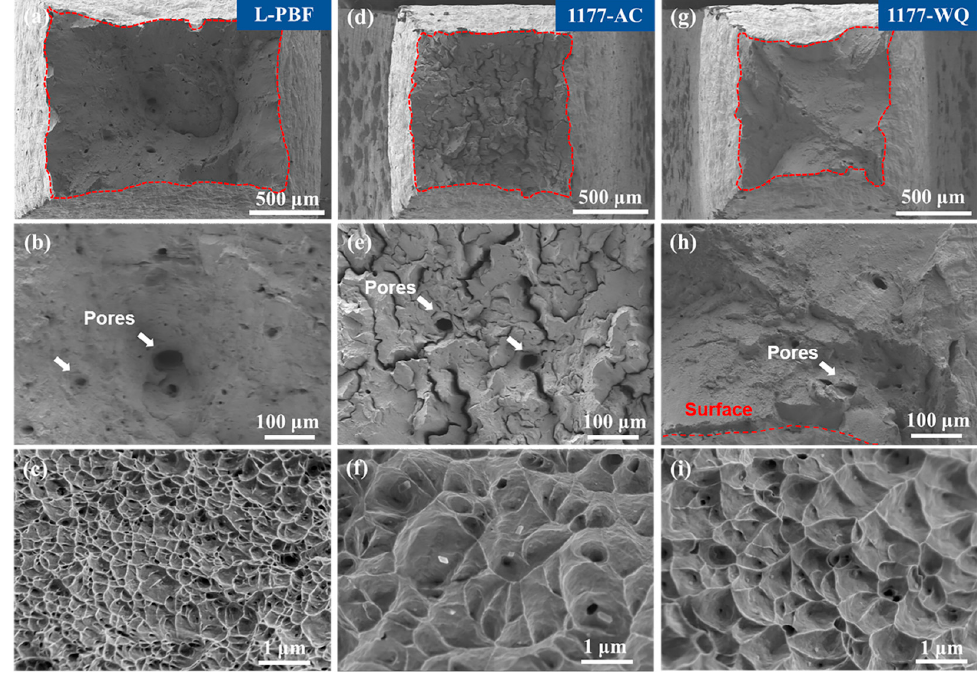
Figure 5. Fracture morphologies of different samples. ( a – c ) In L-PBF condition, ( d – f ) in 1177-AC condition, and ( g – i ) in 1177-WQ condition. The white arrows in ( b , e , h ) indicate the probable inherent pores in fracture surface. The red dotted box highlights the boundary of fracture surface.